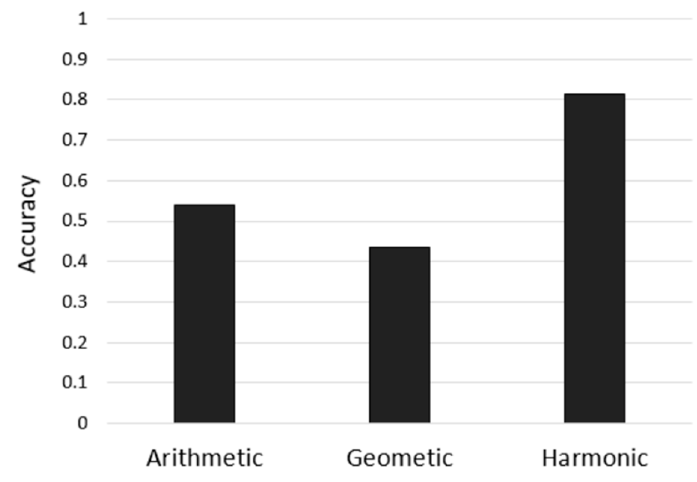
Figure 9. Results of an Accuracy Comparison Between Arithmetic Mean, Geometric Mean, and Harmonic Mean.